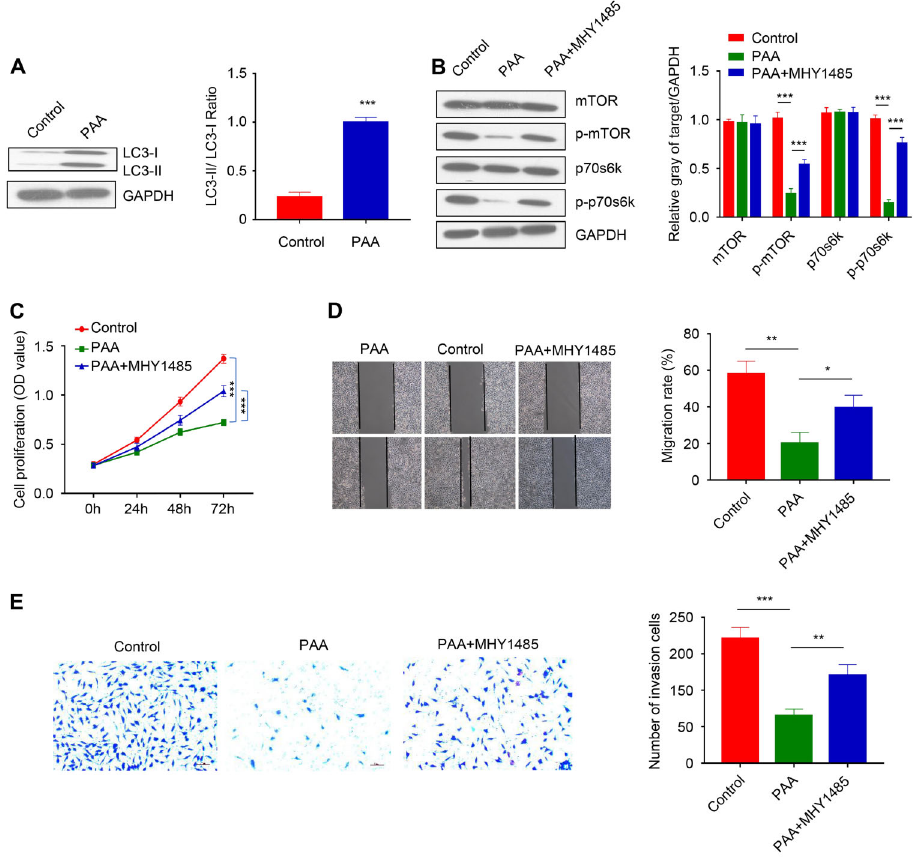
Figure 3. Poricoic acid A (PAA) induced autophagy and suppressed mTOR/p70S6K signaling pathway. A , Western blotting analysis of LC3II and LC3I protein level in control and PAA-treated cells. B , Western blotting analysis of mTOR, p-mTOR, p70s6k, and p-p70s6k levels in control, PAA-treated cells, and cells with PAA and MHY1485 treatment. C , CCK-8 cell proliferation assay in control, PAA-treated cells, and cells treated with PAA and MHY1485 at 0, 24, 48, 72 h. D , Scratch assay in control, cells with PAA treatment, and cells with PAA and MHY1485 treatment. E , Cell invasion assay in control, cells with PAA treatment, and cells with PAA and MHY1485 treatment (scale bar 50 m m). Data are reported as means ± SD of 3 independent experiments. ***P o 0.001, **P o 0.01, *P o 0.05 (two-tailed Student ’ s t -test).